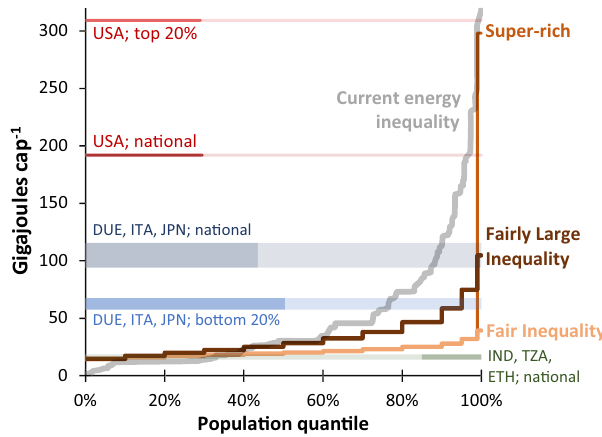
Fig. 2 | Estimates of fi nal energy use per capita across global population quantiles. Finalenergypercapitain2050forthethreeinequalityscenarios,shown averaged across population quantiles for the lowest to highest consumption groups. For comparison the current distribution of fi nal energy is also shown, as well as that for a selection of income groups and countries (from Oswald et al. (2020) 43 ,butwithgovernment&capitalenergyadded).Thesteppedpatternsarise from the distributions produced in the inequality scenarios, which are at a reso- lution of deciles up to the top decile, which is split into three further groups (see Methods for more details). DUE Germany, ITA Italy, JPN Japan, IND India, TZA Tanzania, ETH